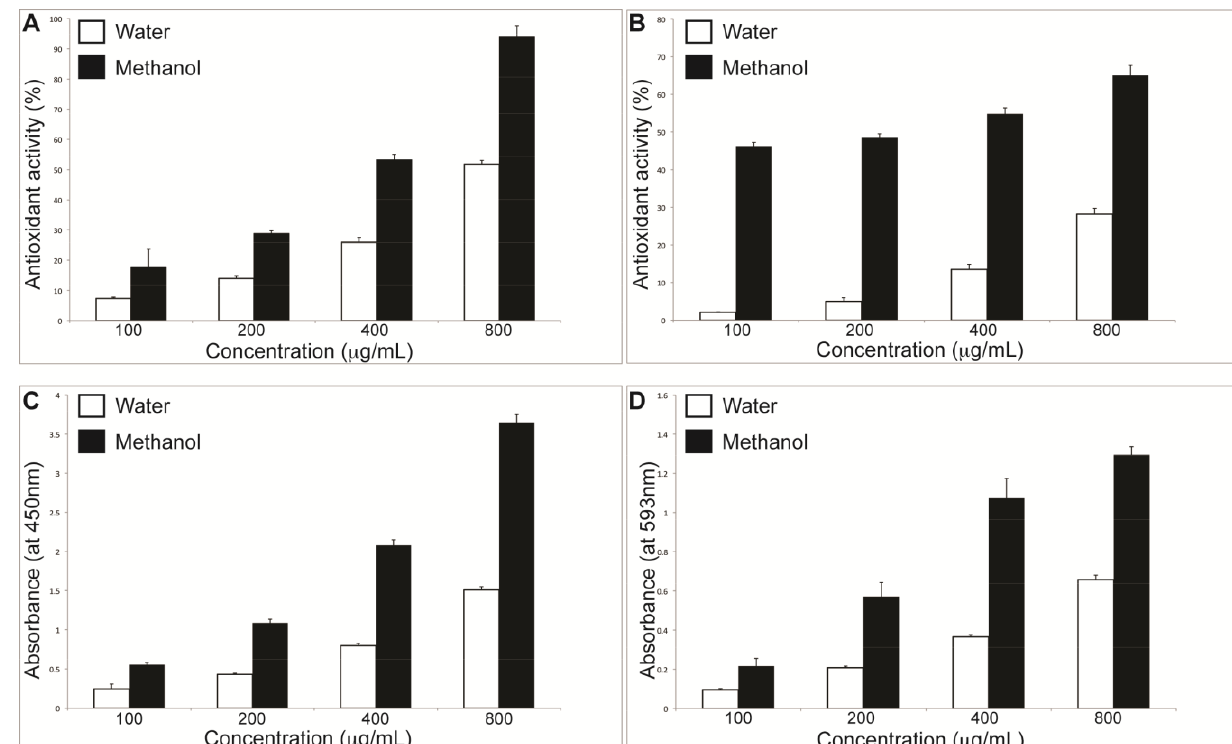
Figure 3. Antioxidant activity of MeOH and water extracts assessed by ABTS ( A ); DPPH ( B ); CUPRAC ( C ); and FRAP ( D ) assays. ABTS: (2,2-azino-bis (3-ethyl-benzothiazoline-6- sulfonic acid); DPPH: (2,2-diphenyl-1-picrylhydrazyl); CUPRAC: cupric reducing antioxidant capacity; FRAP: ferric reducing antioxidant power.